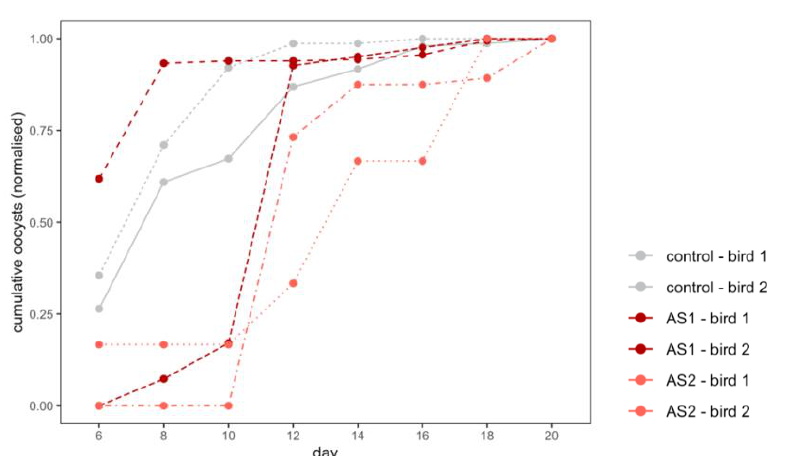
Figure 5: Experiment 3. Cumulative proportion of oocysts per day in mosquitoes infected with the reference (control) and AS-selected lines. Data is provided separately for each